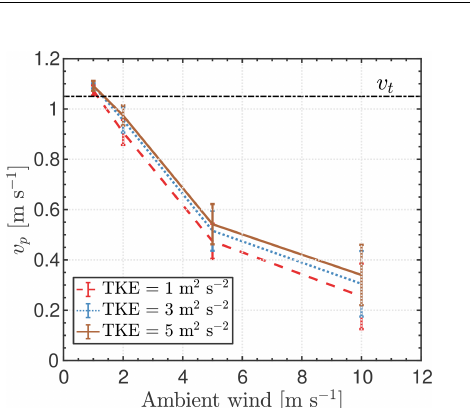
Figure 13. Simulated wind field around the MASC with undis- turbed winds set at 1ms − 1 towards the + y direction. Color rep- , and arrows show wind direc- resents the vertical wind speed v f z tions on the y – z plane. The plane in which the arrows are located is aligned with the center of the aperture on the y – z plane, and x - positive points out of the page.